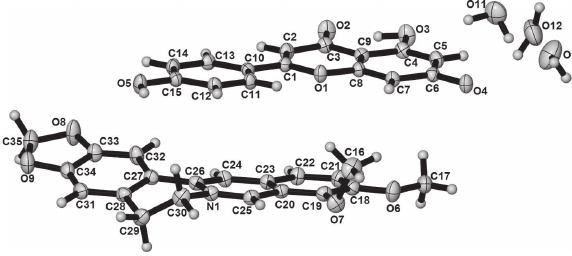
Table 1: Data collection and